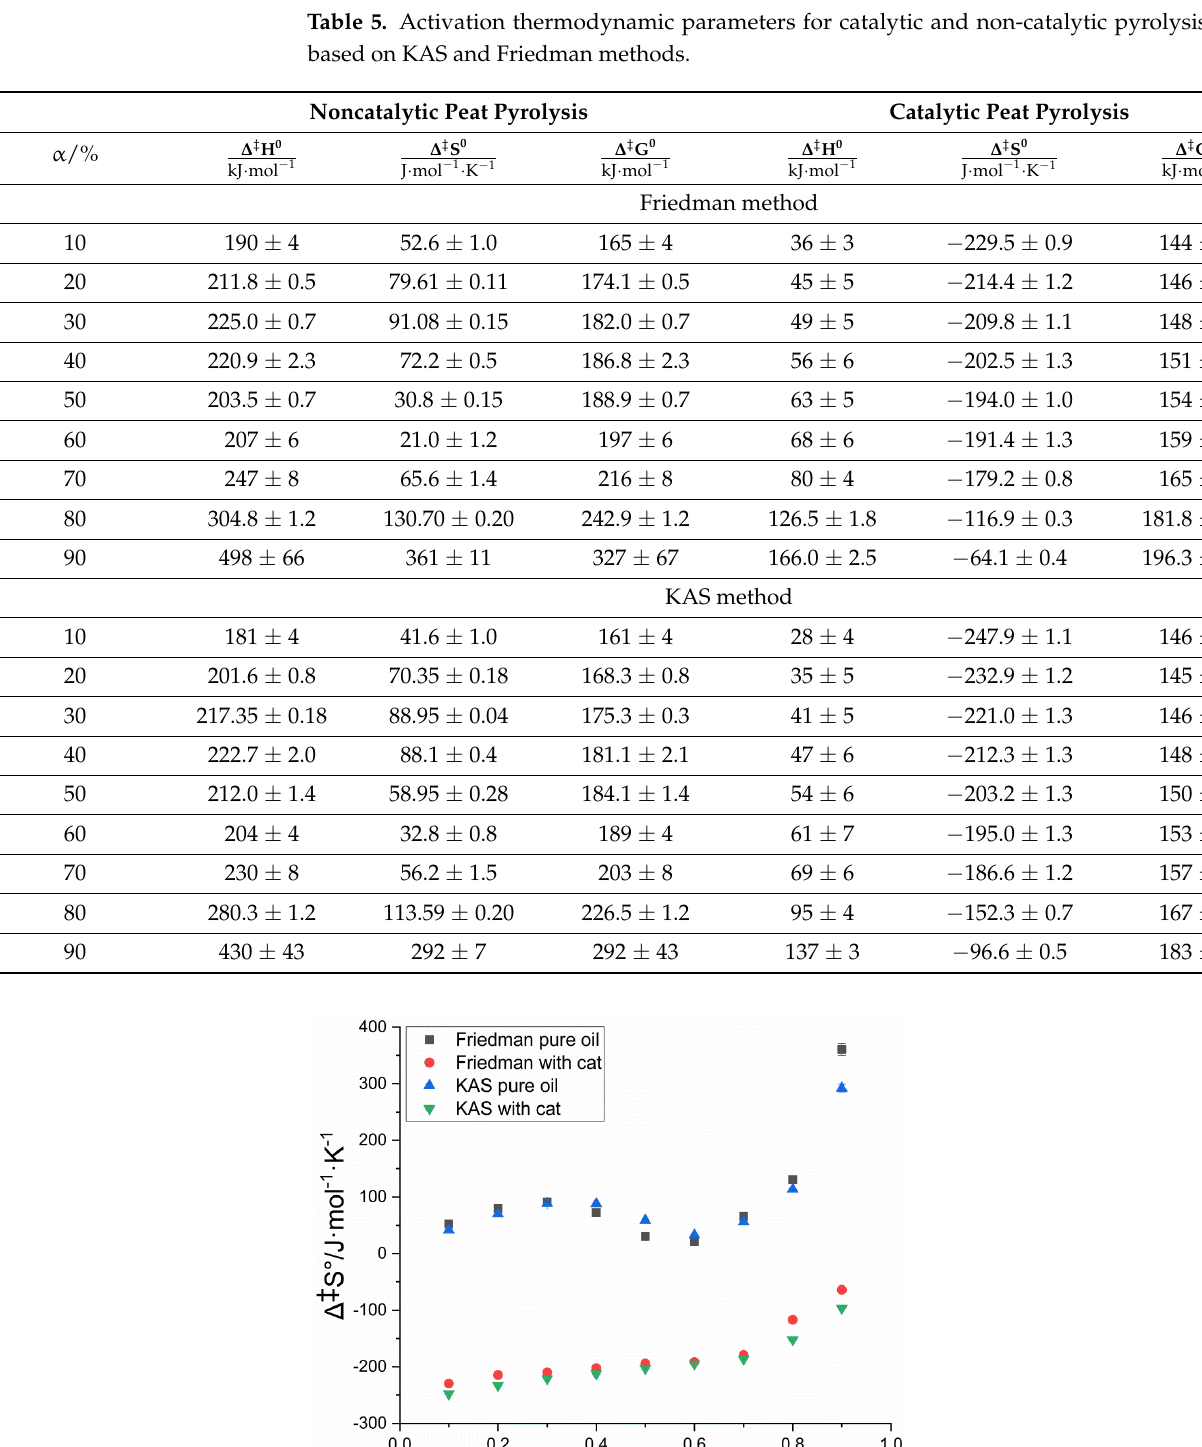
Figure 9. Dependency of the activation Gibbs energy vs. conversion for catalytic and non-catalytic peat pyrolysis.